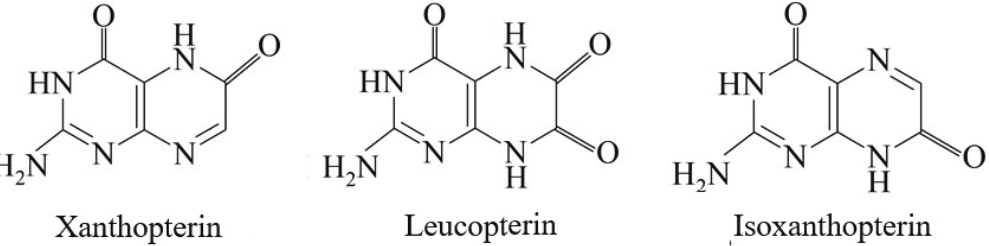
Figure 2: Natural